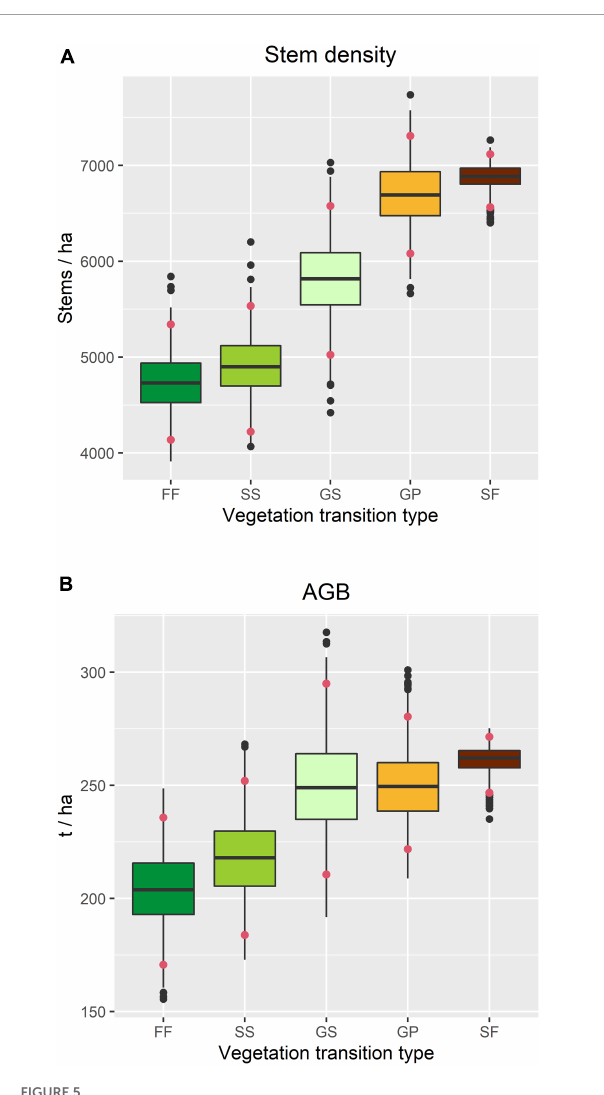
FIGURE5 Structural attributes of the forest within the TPK plot in 2015, based on census data associated with each vegetation transition type. (A)